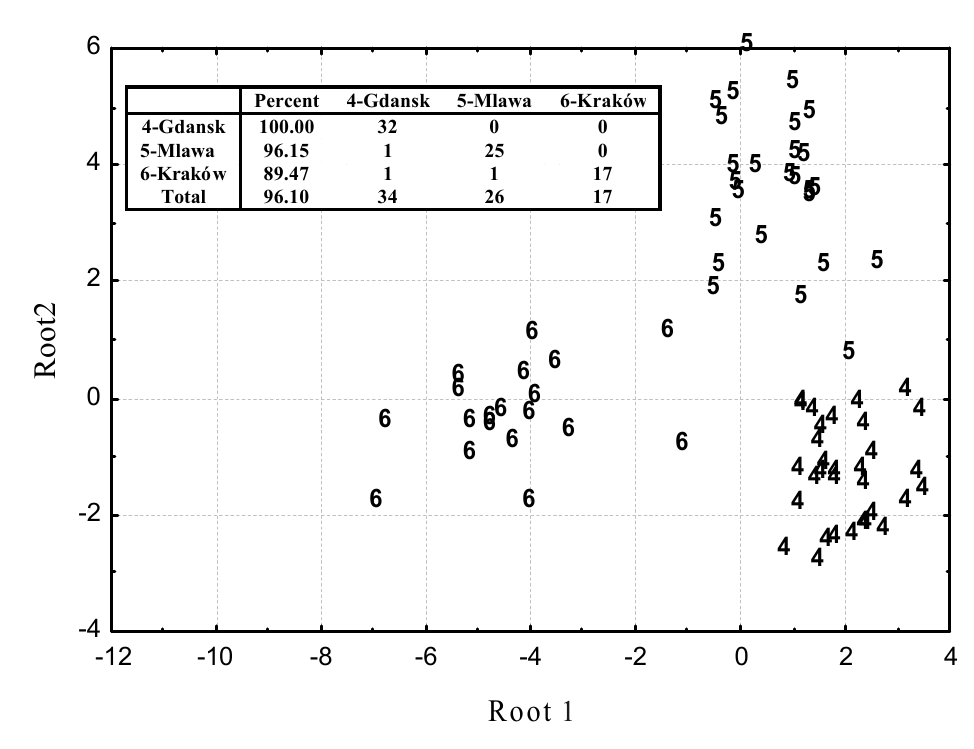
Figure 3. Scatterplot of canonical scores on the plan described by root